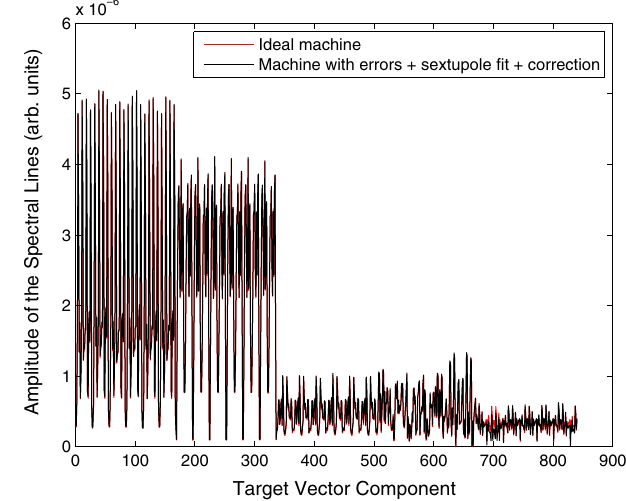
FIG. 2. (Color) Same comparison as in Fig. 1 after the sextu- poles have been corrected with the fit procedure outlined in Sec. II. Notice that the vertical scale in this plot is smaller by roughly a factor of 4 compared to Fig. 1. The nominal model for the Diamond bare lattice is in red and the machine model with random errors in the sextupole component and their correction in black. Notice also that the red line is barely visible underneath the black line. This demonstrates how well this correction technique may work.